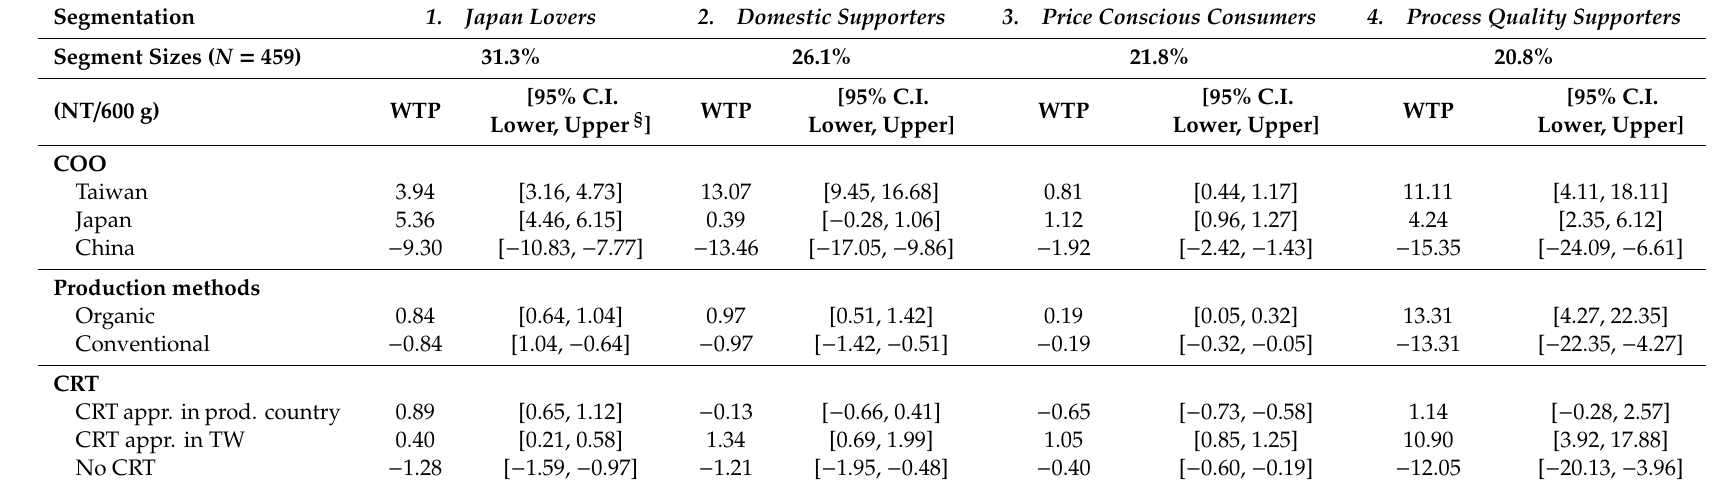
Table 6. Willingness to pay of di ff erent consumer